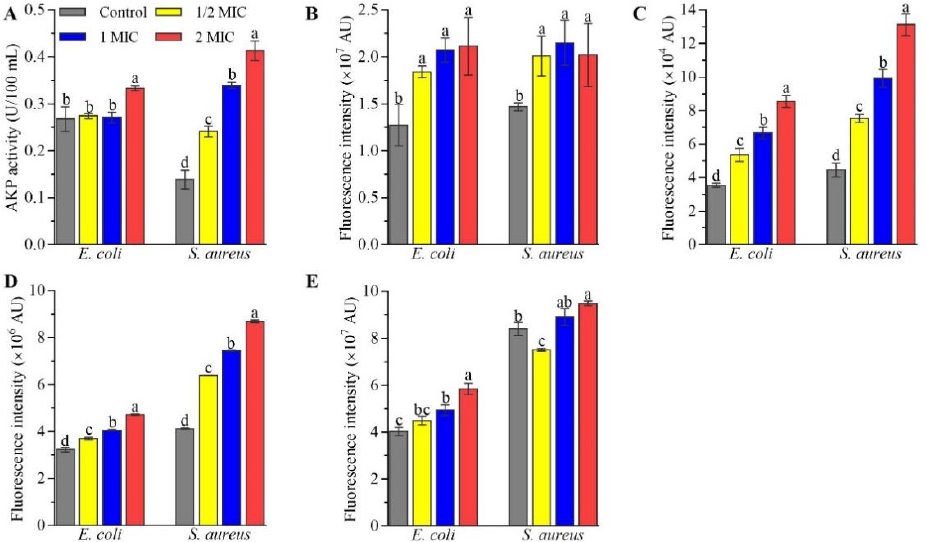
Figure 4. Effects of CFS from L. rhamnosus SCB0119 on AKP contents ( A ), outer membrane permeability ( B ), inner membrane integrity ( C ), membrane potential ( D ) and pH gradients ( E ) in E. coli ATCC25922 and S. aureus ATCC6538. Changes in the outer membrane permeability, inner membrane integrity, membrane potential, and pH gradients were assayed using NPN, PI, DiBAC4(3), and BCECF-AM staining, respectively. Different lowercase letters indicate significant differences among the treatments ( p < 0.05). Error bars: SD of the mean from three repeated assays.